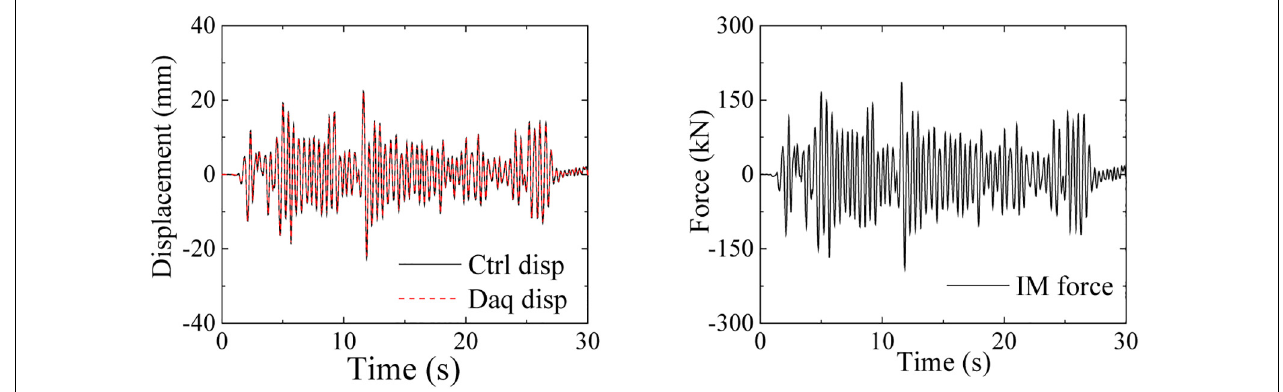
FIGURE 8 | Time histories of the shear force and deformation (IM